Question: Name the type of graph shown.
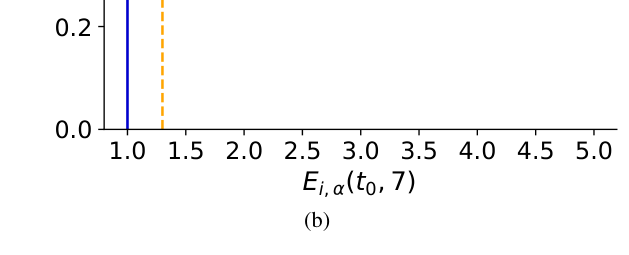
Answer: line